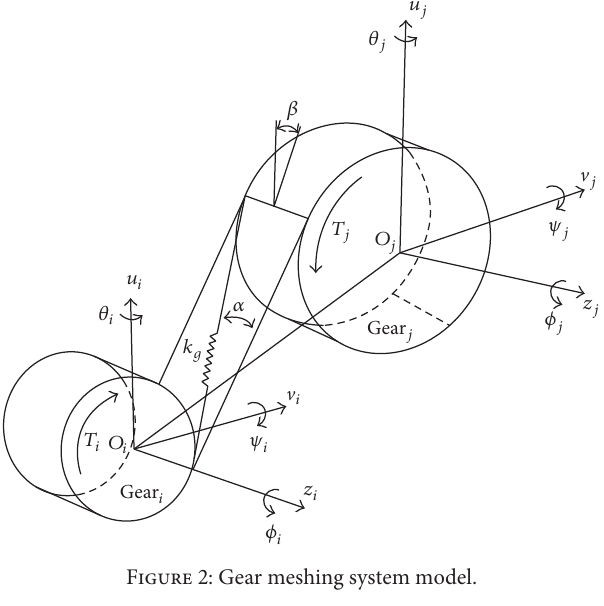
Figure 2: Gear meshing system model.